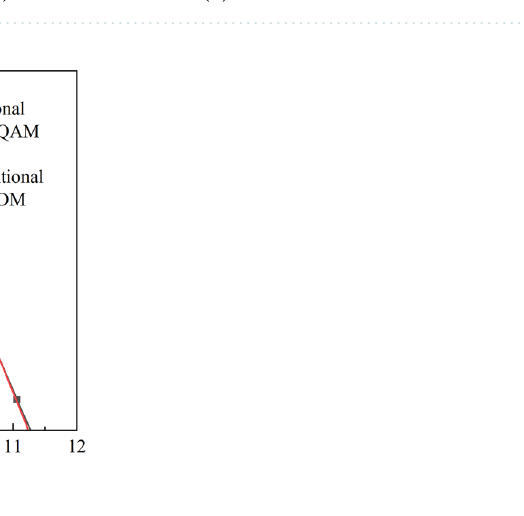
Figure 3. Simulated ambiguity functions of the ( a ) PHYDYAS filter and ( b ) Hermite filter.